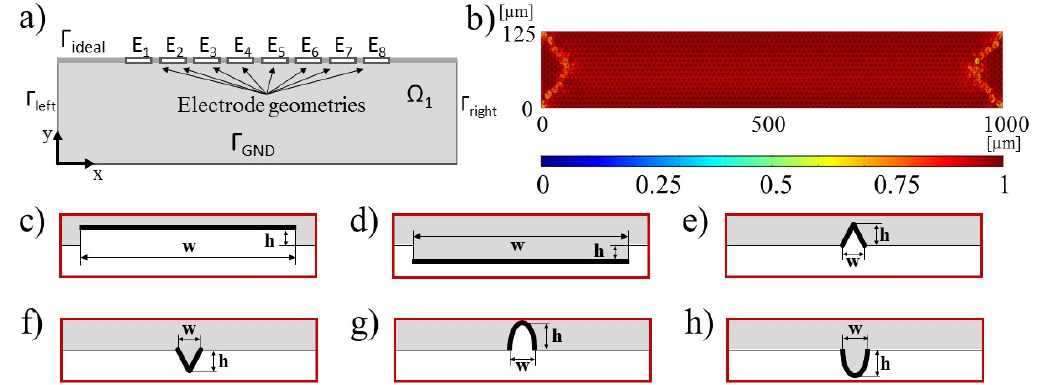
Figure 4. ( a ) Schematic of COMSOL SDE model; ( b ) Generated mesh for ideal electric potential boundary condition (BC); ( c ) Step electrode; ( d ) Channel electrode; ( e ) Pin electrode; ( f ) Notch electrode; ( g ) Parabolic pin electrode; ( h ) Parabolic notch electrode.